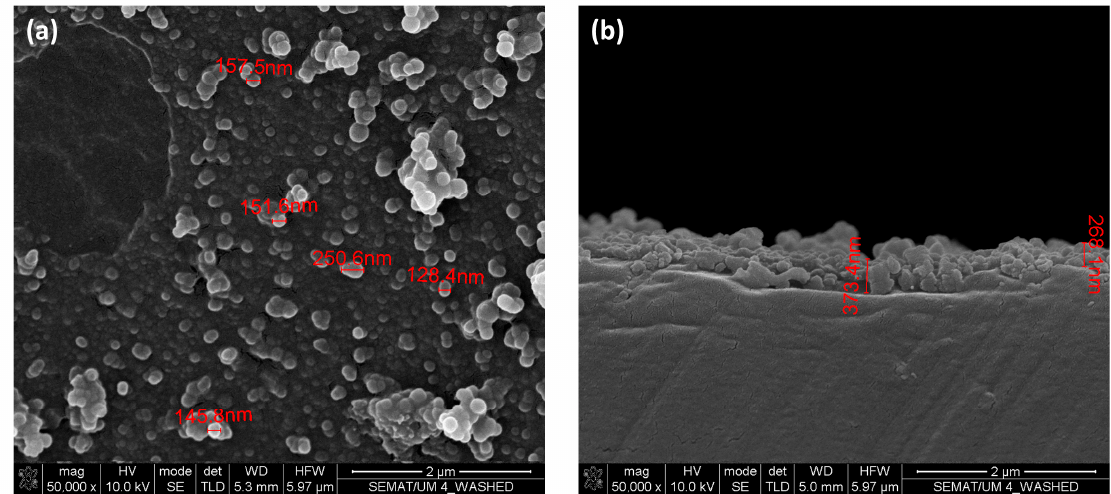
Figure 6. SEM images of PET NP modified surface after 10 cycles of water and ethanol washing: ( a ) top view—50,000 × and ( b ) cross-section view—50,000 × .